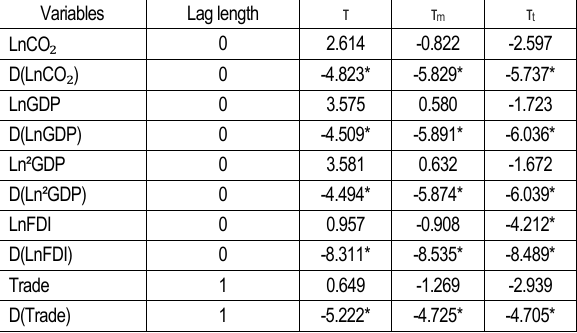
Table 1. Unit root test for all variables